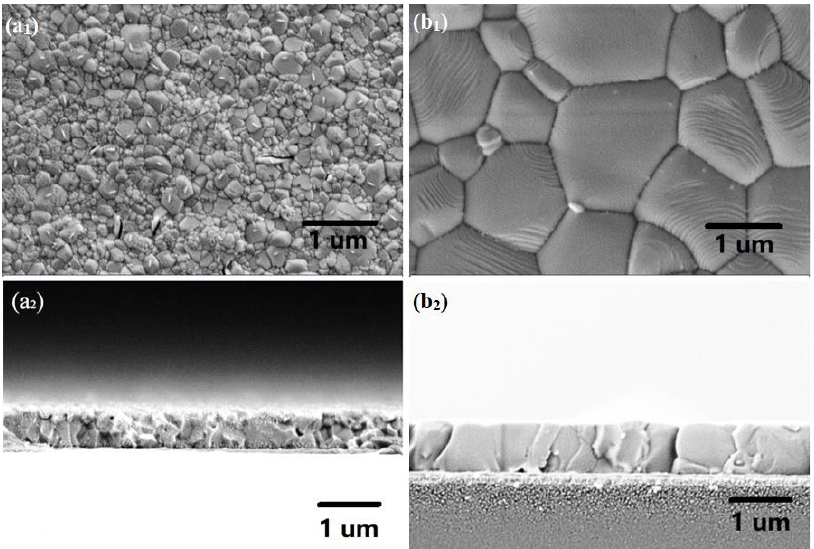
Figure 2. SEM images of as-prepared ( a 1 : surface; a 2 : cross-section) and solvent-annealed ( b 1 : surface; b 2 : cross-section) CH 3 NH 3 PbI 3 films.